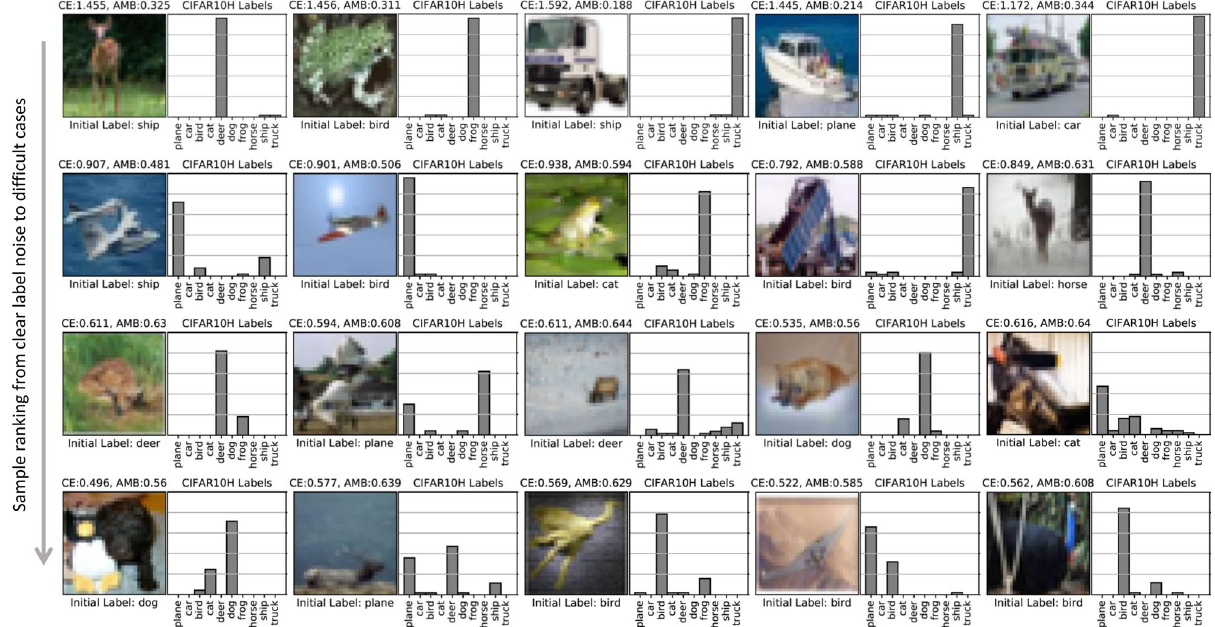
Fig. 4 Ranking of CIFAR10H samples (15% initial noise rate) by the SSL-Linear algorithm. The top row illustrates a representative subset of images ranked at the top-10 percentile with the highest priority for relabelling. Similarly, the second and third rows correspond to 25 – 50 and 50 – 75 percentiles, respectively. At the bottom, ambiguous examples that fall into the bottom 10% of the list ( N = 2241) are shown. Each example is shown together with its true label distribution to highlight the associated labelling dif fi culty. This can be compared against the label noisiness (cross-entropy; CE) and sample ambiguity (entropy; AMB) scores predicted by the algorithm (see Eq. (2)), shown above each image. As pointed out earlier, adjudication of samples provided at the bottom does require a large number of re-annotations to form a consensus. The authors in ref. 26 explore the causes of ambiguity observed in these